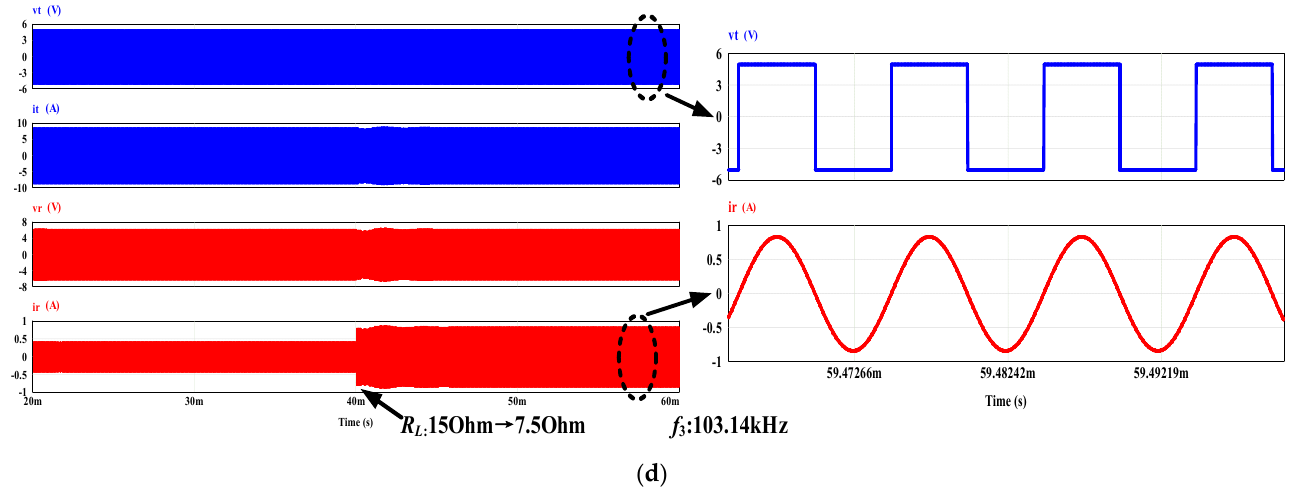
Figure 6. The waveforms of v t , i t , v r , and i r at the four load-independent CV output frequencies ( a ) f 0 , ( b ) f 1 , ( c ) f 2 , and ( d ) f 3 . ( b ) f 1 , ( c ) f 2 , and ( d ) f 3 .